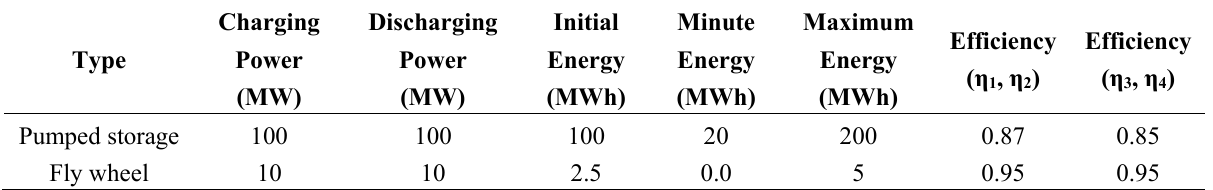
Table 3. Parameter representations of the pumped storage station and the fly wheel power